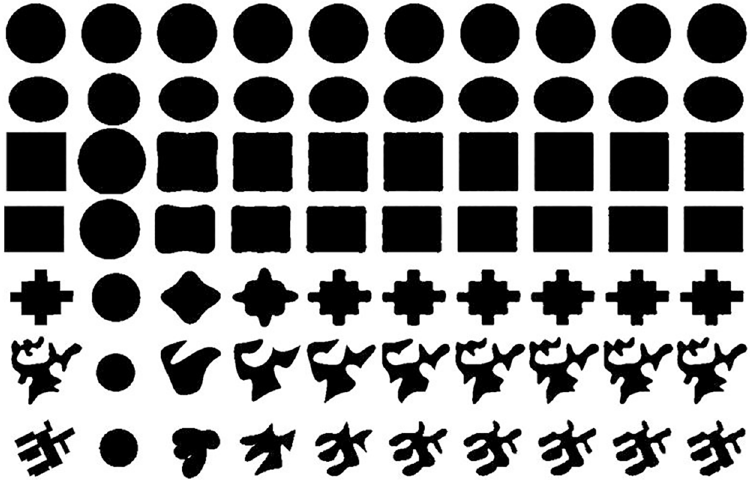
Fig 1. The polygon approximation by Fourier descriptors for different shape types at different interceptive